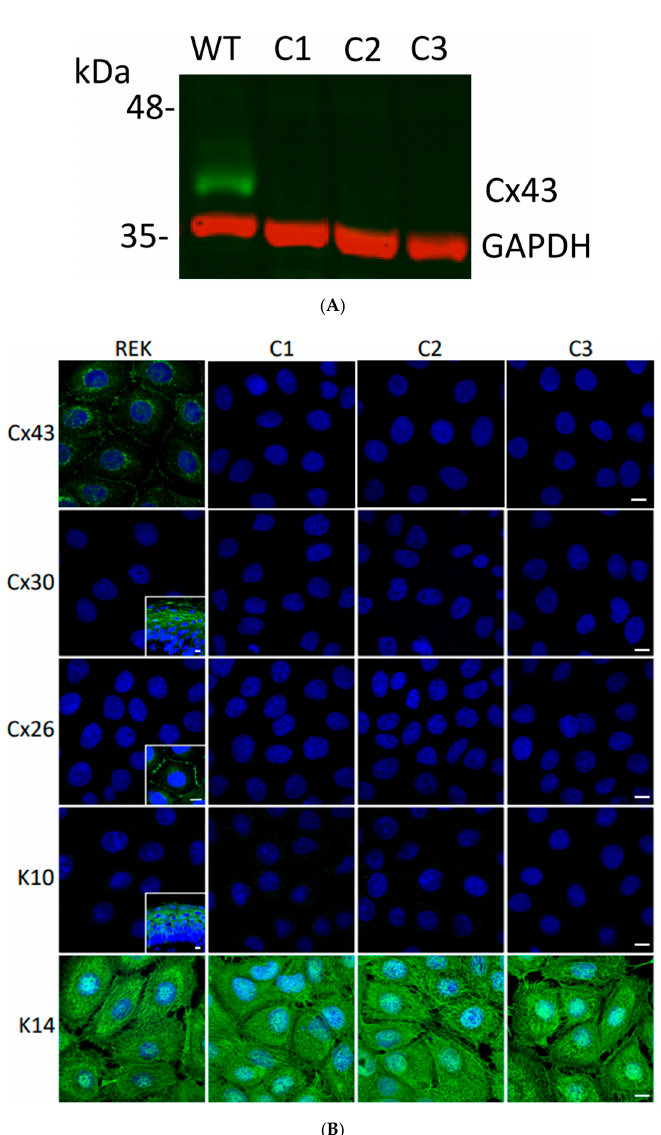
Figure 3. Ablation of Cx43 did not act to stimulate connexin reprogramming or differentiation of REKs. ( A ) CRISPR-Cas9 was effectively used to ablate Cx43 from REKs as revealed by immunoblotting wild-type (WT) and three separate clones (C1, C2, C3) for Cx43. Immunoblotting for GAPDH was used as a loading control. ( B ) Immunofluorescent labeling for Cx43, Cx26 and Cx30 revealed that Cx43 was ablated from all three CRISPR-Cas9 treated clones and neither Cx26 nor Cx30 exhibited increased expression to compensate for the loss of Cx43. Immunolabeling for keratin 10 (K10) and keratin 14 (K14) revealed that REKs retained their basal cell characteristics upon Cx43 ablation. Inserts represent transverse or en face sections of mouse skin as positive controls for anti-Cx30 and anti-K10 antibodies while normal rat kidney cells engineered to express Cx26-GFP were used as a positive control for the anti-Cx26 antibody. Nuclei were stained with Hoechst dye. Bars = 10 µ